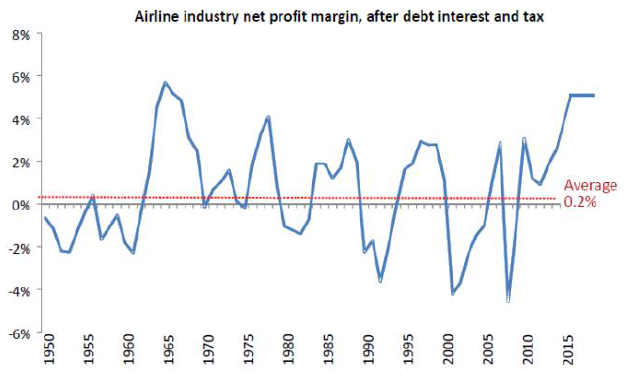
Figure 1: Airline Industry Net Profit Margin After Debt Interest and Tax; Source: (IATA,